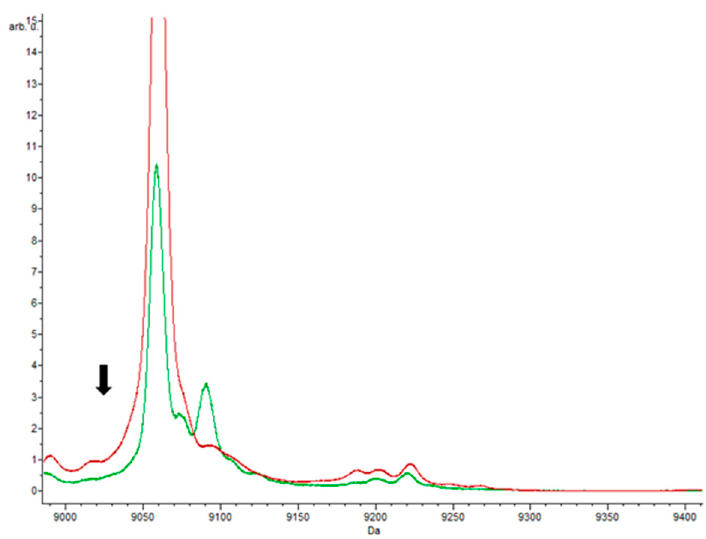
Figure 4. Peaks at 9089.69 m / z . The characteristic peak obtained with the antibiotic ampicillin (green) vs without antibiotic (red). The p -value is 0.0000359, making this peak statistically significant, and is exclusive to ampicillin